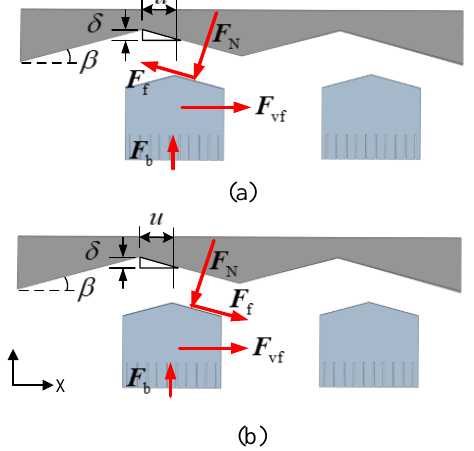
Figure 5. Force analysis of sliding block ( a ) loading; ( b ) unloading. The resisting force F b of the buckling-plate is dependent on its axial